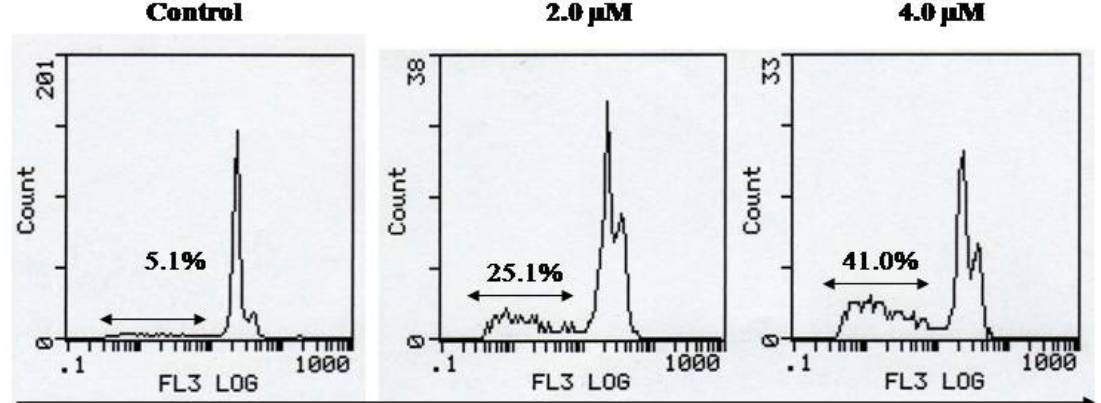
Figure 3. Effect of 1a on the induction of apoptosis in A549 cells. Cells were treated with 2.0 µM and 4.0 µM of 1a for 48 h. The cells in the sub-G apoptotic cells (n =